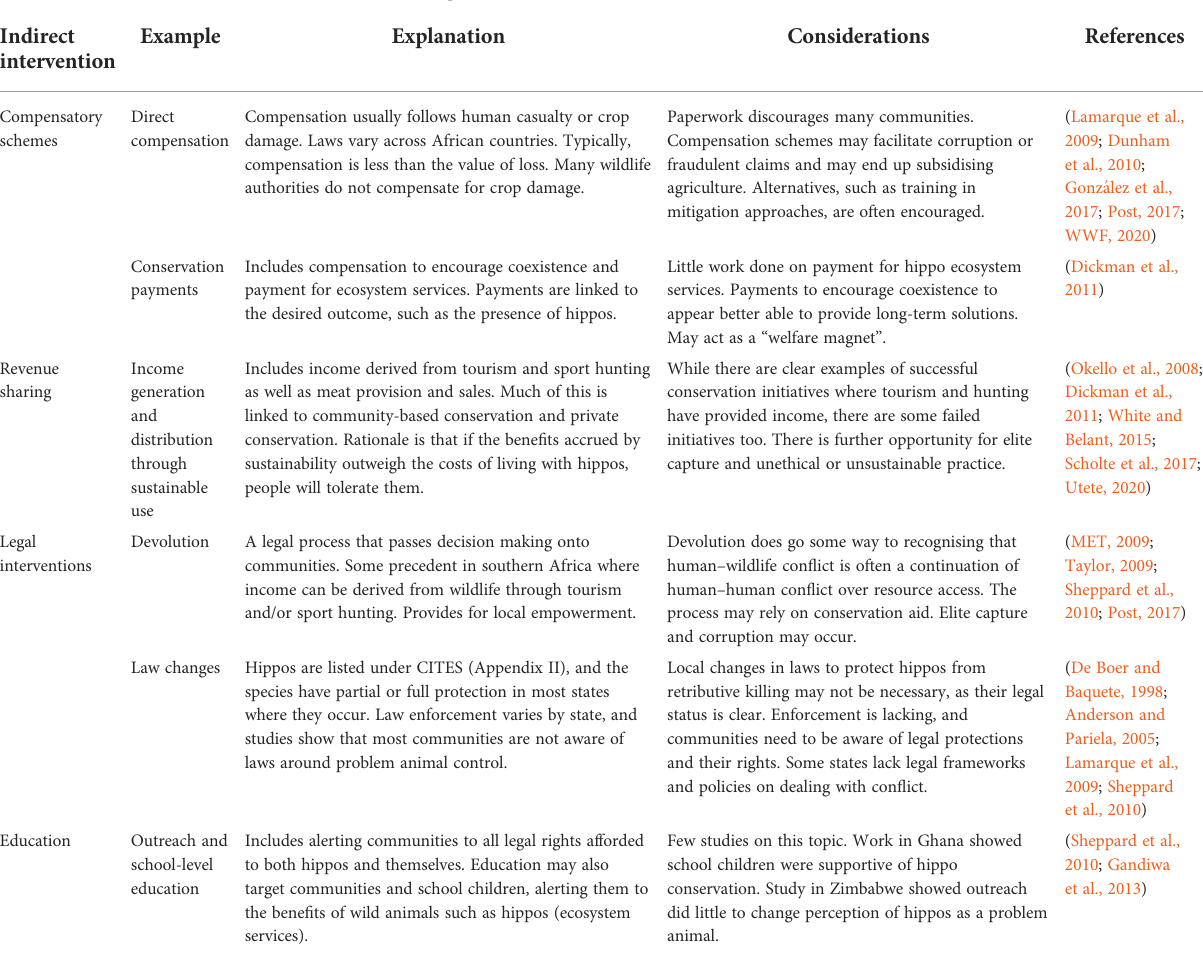
TABLE 1B Indirect intervention measures used to mitigate